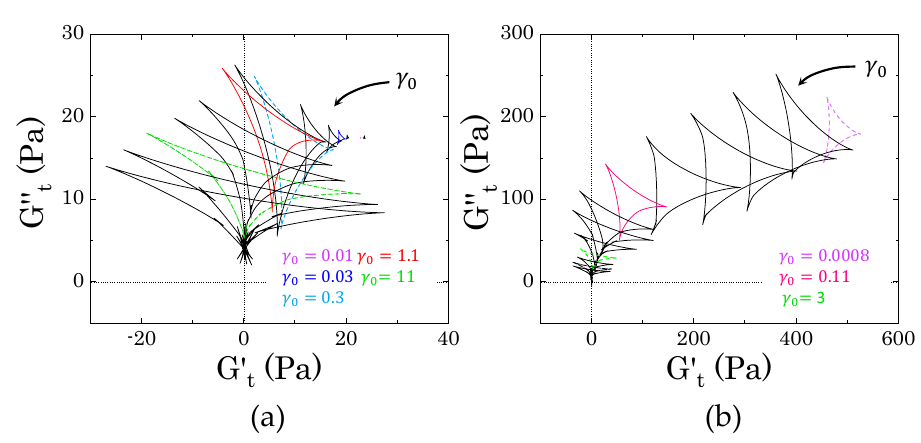
Figure 12. Evolution of the Cole–Cole plots at increasing strain amplitudes for two samples at 0.9% wt of Carbopol ( a ) in the absence of mannitol (sample M0) and ( b ) with mannitol in the presence of crystals (sample M2). All of the deltoids corresponding to the most relevant transitions observed in Figure 7b are marked with a specific colour. For panel ( a ), dashed purple line: first point deviating from the linear viscoelastic plateau; blue solid line: peak of G (cid:48)(cid:48) ; cyan dashed line: local minimum of G (cid:48)(cid:48) ; red solid line: second peak of G (cid:48)(cid:48) ; green dashed line: beginning of final strain-thinning behaviour. For panel ( b ), dashed purple line: first point deviating from the linear viscoelastic plateau; magenta solid line: end of the first decay of G (cid:48)(cid:48) , green dashed line: beginning of final strain-thinning